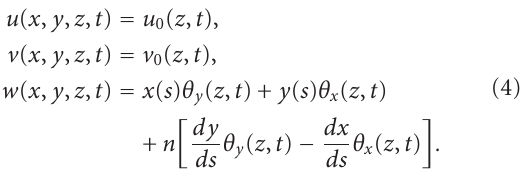
height b ( η ) of the midline cross-sectional profiles are repre- sented as